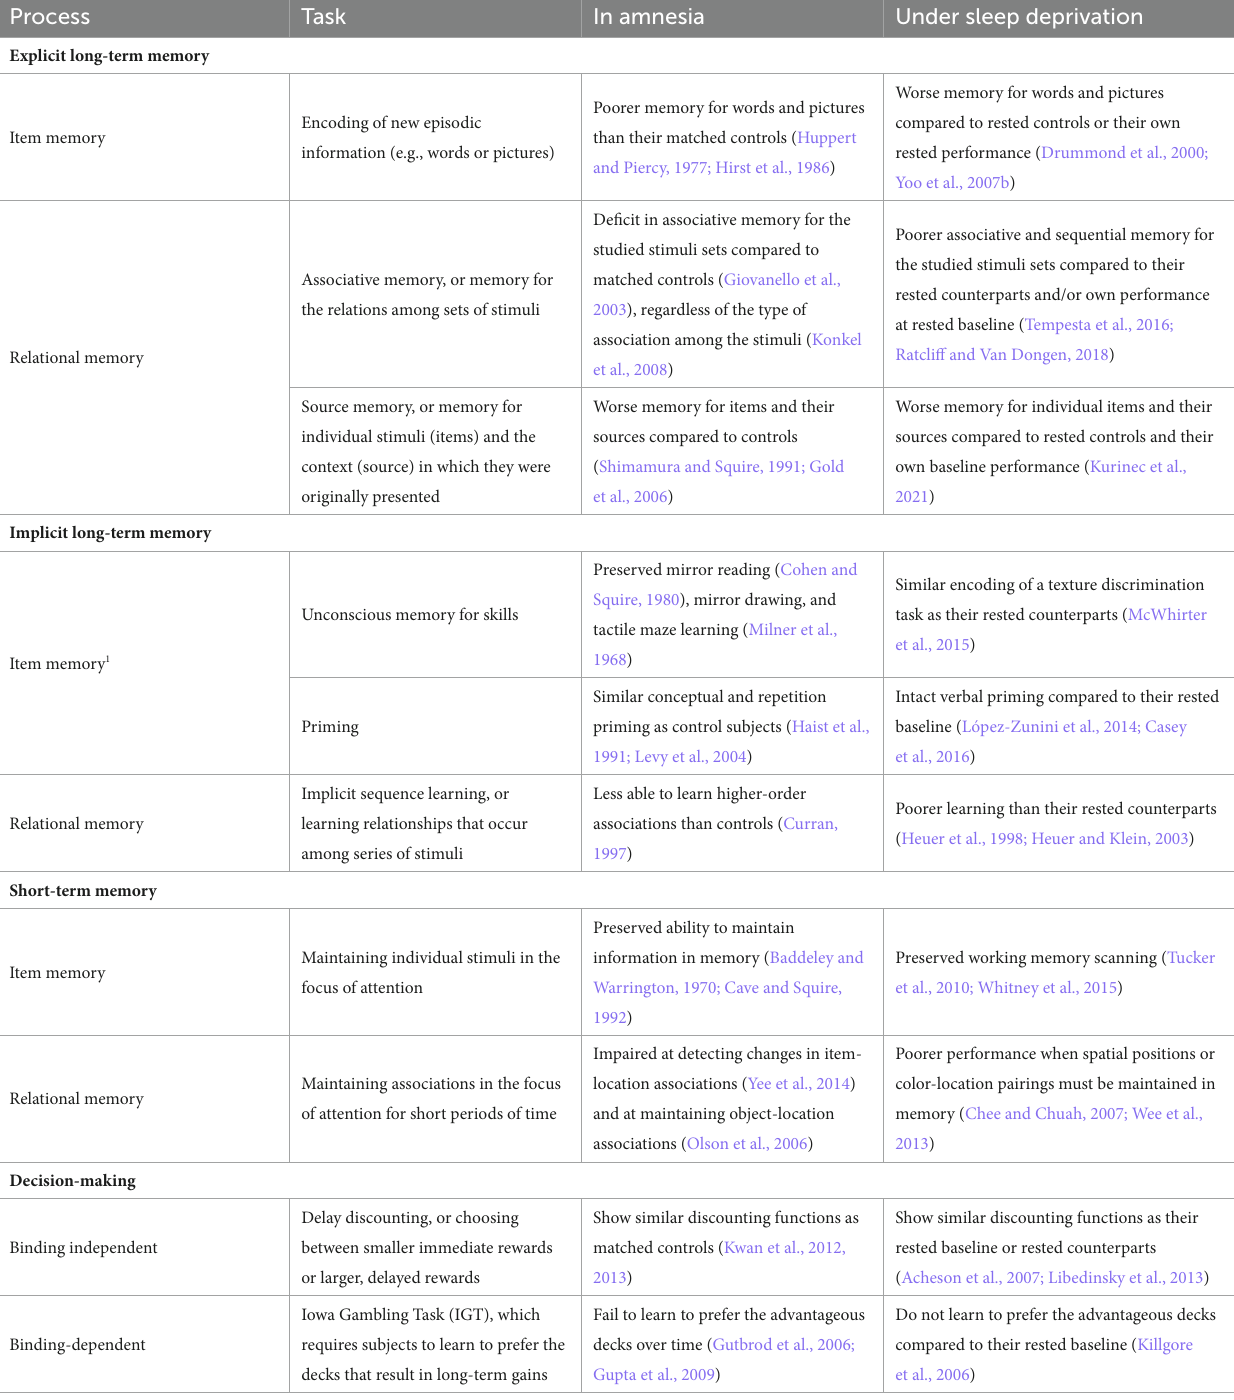
TABLE 1 Comparison of preserved and impaired memory processes in amnesia and sleep deprivation. Process Task In amnesia Under sleep